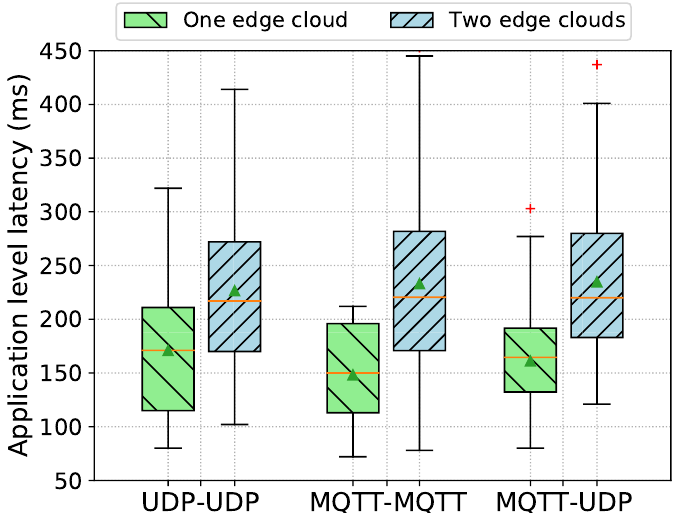
Figure 8. Application-level latency between OBUs measured for three different combinations of V2X communication protocols between the sender and the receiver OBUs. One edge cloud represents that both OBUs connected to the same edge cloud, whereas two edge clouds represent that each OBU is connected to a different edge